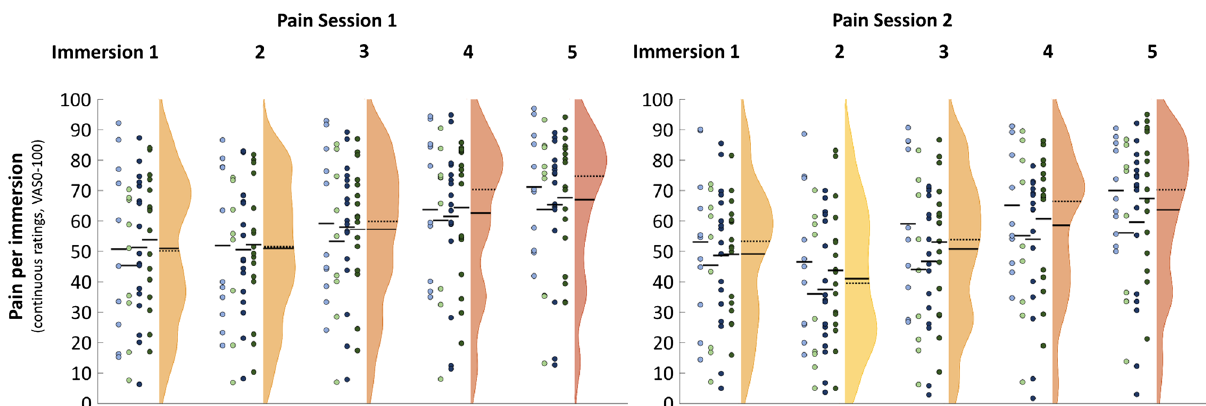
Figure 4. Pain ratings over both experimental sessions. Dot columns/colors indicate experimental groups (factor combinations of Delivery*Expectancy; column 1 light blue Text/NT, column 2 light green VEx/NT, column 3 blue Text/PBO, column 4 green VEx/PBO). Violins show full sample distribution, mean (solid line) and median (dotted line) per